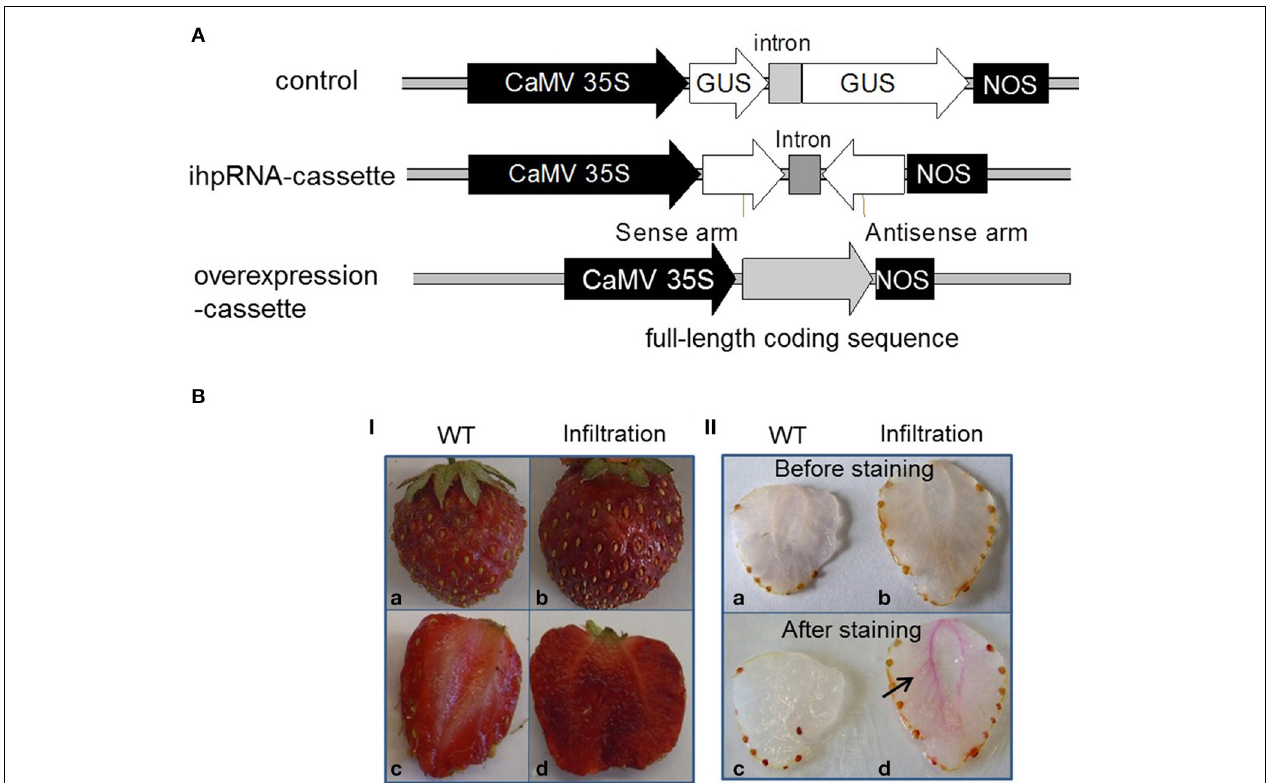
FIGURE 5 | Schematic diagram of constructs (A), and phenotype (I) and lignin staining (II) of wild-type and infiltrated fruits (B). (A) All constructs are in the binary vector pBI121. CaMV 35S, the 35S promoter of cauliflower mosaic virus ; intron, the second intron of strawberry FaQR gene (Raab et al., 2006); NOS, terminator of the nopaline synthase gene. A control construct (pBI-intron) contained a GUS gene interrupted by an intron; an ihpRNA- cassette construct contained an intron flanked by partial coding sequences (300bp) of target genes ( FaCCR , FaCAD , or FaPOD ) in sense and antisense orientations; an overexpression-cassette comprised the full-length coding